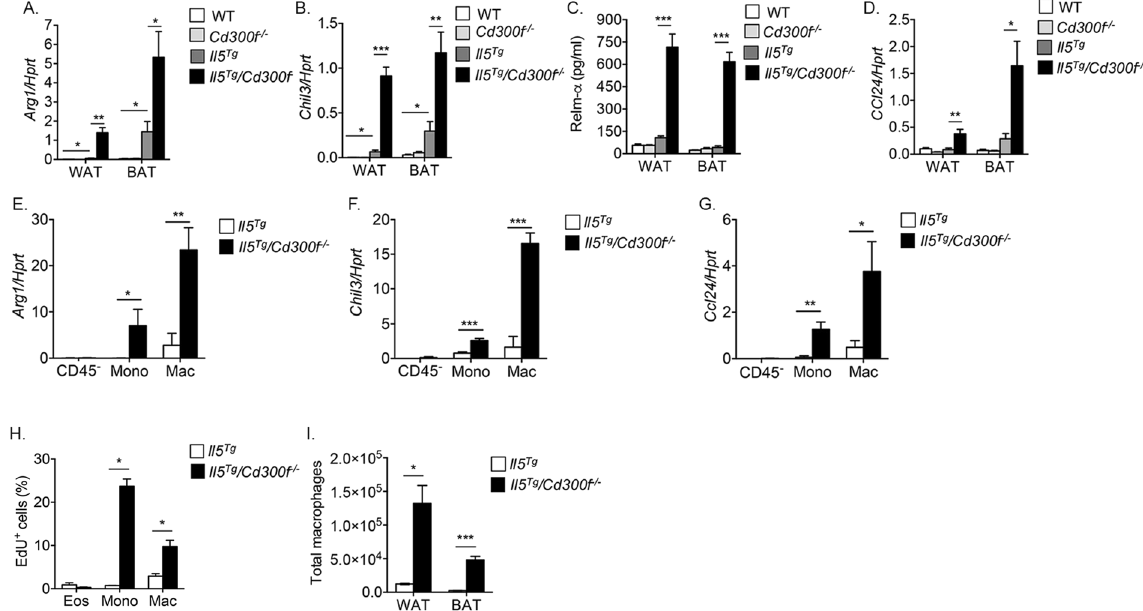
Figure 4. CD300f-IL-5 receptor cross talk regulates alternatively activated macrophage formation in adipose tissue. The expression of hallmark alternatively activated macrophage markers such as Arg1 , Chi3l , Relm- α and Ccl24 were determined in the adipose tissue of wild type (WT), Cd300f − / − , Il5 Tg and Il5 Tg /Cd300f − / − mice by quantitative PCR and normalized to the house keeping gene hypoxanthine-guanine phosphoribosyltransferase ( Hprt ) ( A , B and D ) and ELISA ( C ). Furthermore, the expression of Arg1 , Chi3l , and Ccl24 was determined in the primary adipose tissue macrophages that were sorted from Il5 Tg and Il5 Tg /Cd300f − / − mice by quantitative PCR ( E – G ). In situ proliferation of adipose tissue eosinophils, macrophages and monocytes was assessed in Il5 Tg and Il5 Tg /Cd300f − / − mice using flow cytometric analysis of EdU + cells ( H ). Thereafter, total WAT and